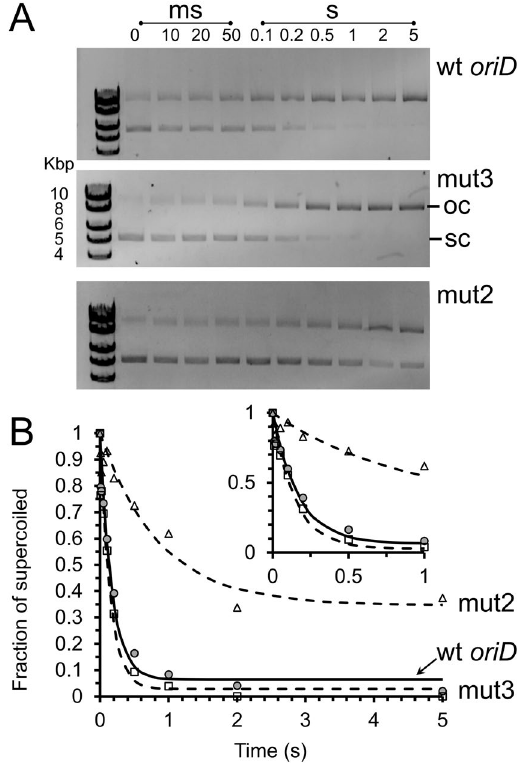
Figure 8. Kinetics of supercoiled plasmid nicking. ( A ) Intact natively-supercoiled (10 kbp) plasmid was rapidly mixed with RepD in K100 buffer at 23 °C. The reaction was quenched by addition of excess EDTA at the time points noted above the gel lanes. The reaction products were electrophoresed on 1% agarose gels in the presence of ethidium bromide. Lower band was the fast-migrating intact, supercoiled plasmid (sc), the upper band, is the slow-migrating nicked, open circular form (oc). ( B ) Quantitation of RepD nicking by gel densitometry gave the proportion nicked (normalized as oc/(oc + sc)) as a function of time. The least-squares fitted lines are to a single exponential function, giving rate constants, 6 s − 1 , 7 s − 1 and 1.2 s − 1 (wt oriD , filled-circles solid-line; mut2 open- triangles, dotted-line, and mut3, open-squares, dotted-line). The inset plot shows data on a faster timescale. RepD nicking of wt oriD and mut3 was complete whereas mut2 had an amplitude of 60%. Experiments were conducted at 23